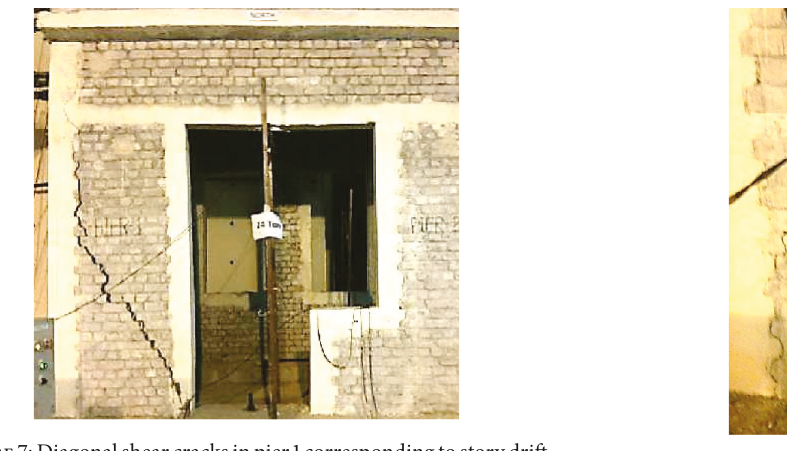
Figure 10: Cracking of toe in pier 1 corresponding to story drift of 0.73%.